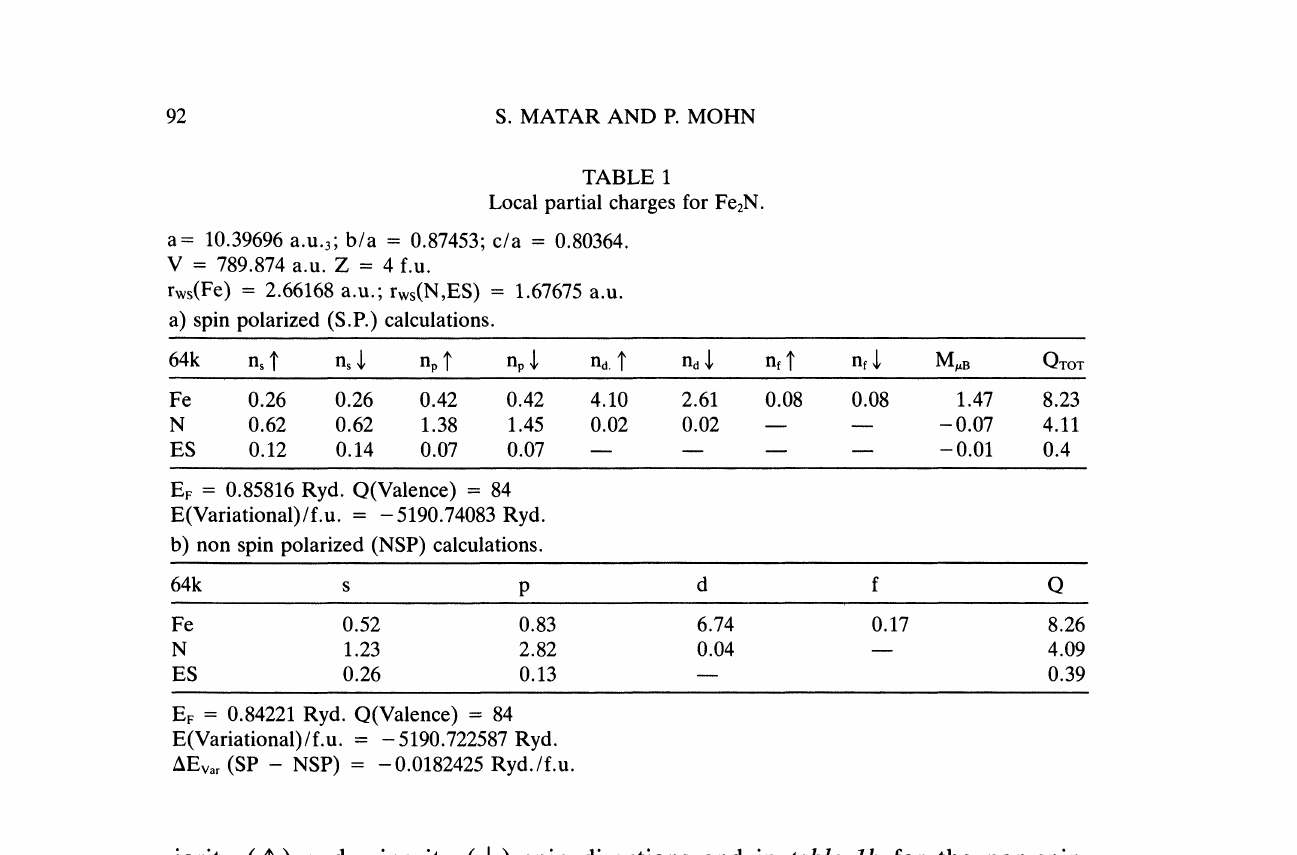
Local partial charges for